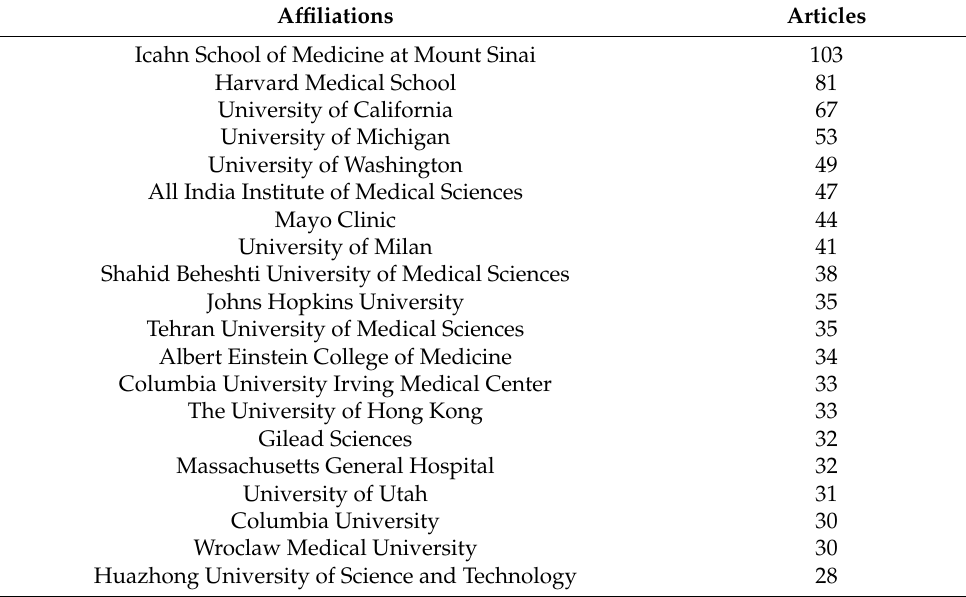
Table 6. Most relevant affiliation and number of